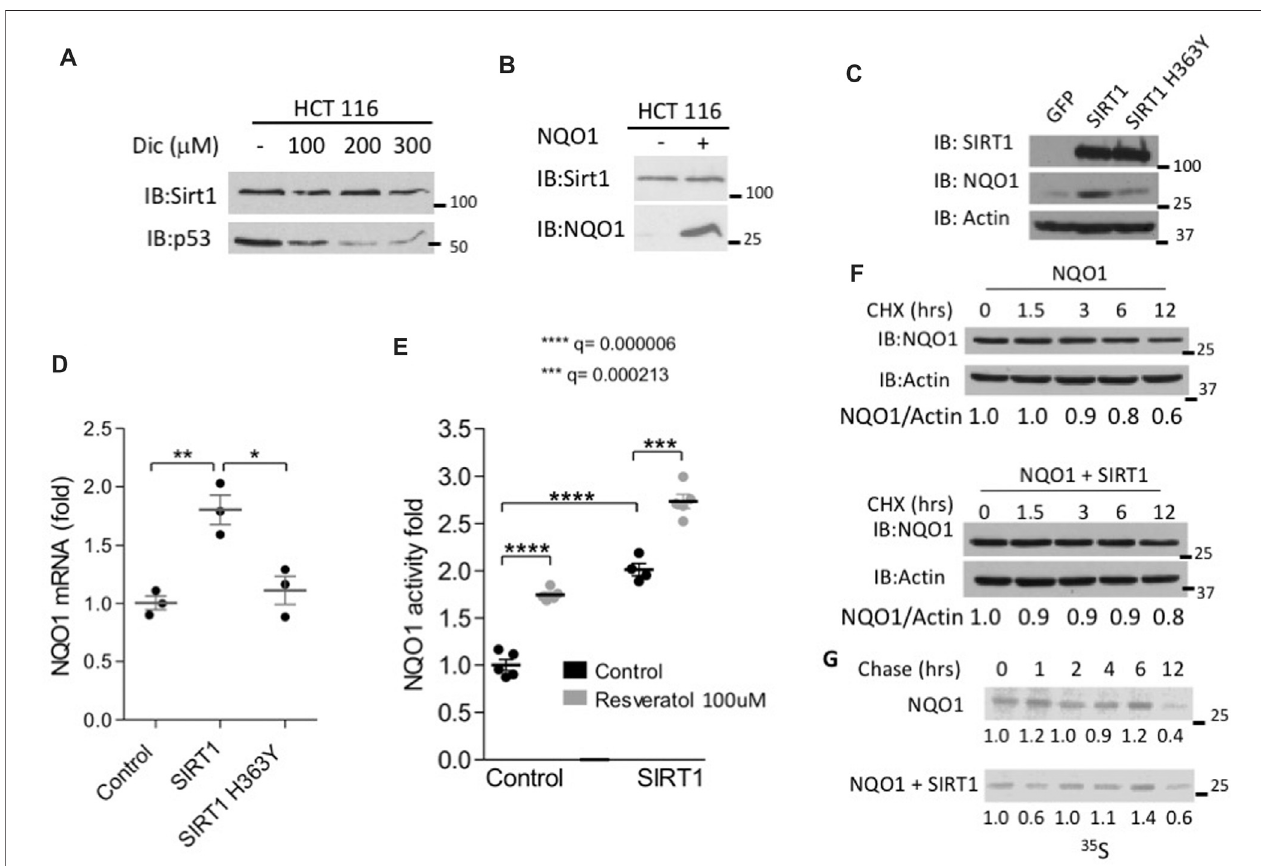
FIGURE 2| SIRT1 increasesthe endogenous NQO1 expression and protein level. (A) HCT116 cells were treated with indicated concentrations of dicoumarol and the level of SIRT1 and p53 were analyzed by Western blotting. (B) The protein level of SIRT1 was analyzed in HCT116 control and NQO1 overexpressing cells. NIH3T3 stablyoverexpressingSIRT1,mutantH363YSIRT1orGFPasacontrolwereexaminedfortheNQO1proteinlevel (C) ,mRNAlevel (D) andactivity (E) inthepresenceor absenceofResveratrolasindicated,for16 h.ThestabilityofNQO1wasexaminedinHEK293cellsoverexpressingNQO1inthepresenceorabsenceof fl ag-SIRT1 followingcycloheximidetreatment(100 μ g/ml)atindicatedtimepoints (F) orfollowingpulselabelingwith 35 SMethionineandharvestingatindicatedtimepointsfollowing the addition of unlabeled methionine (chase) (G)